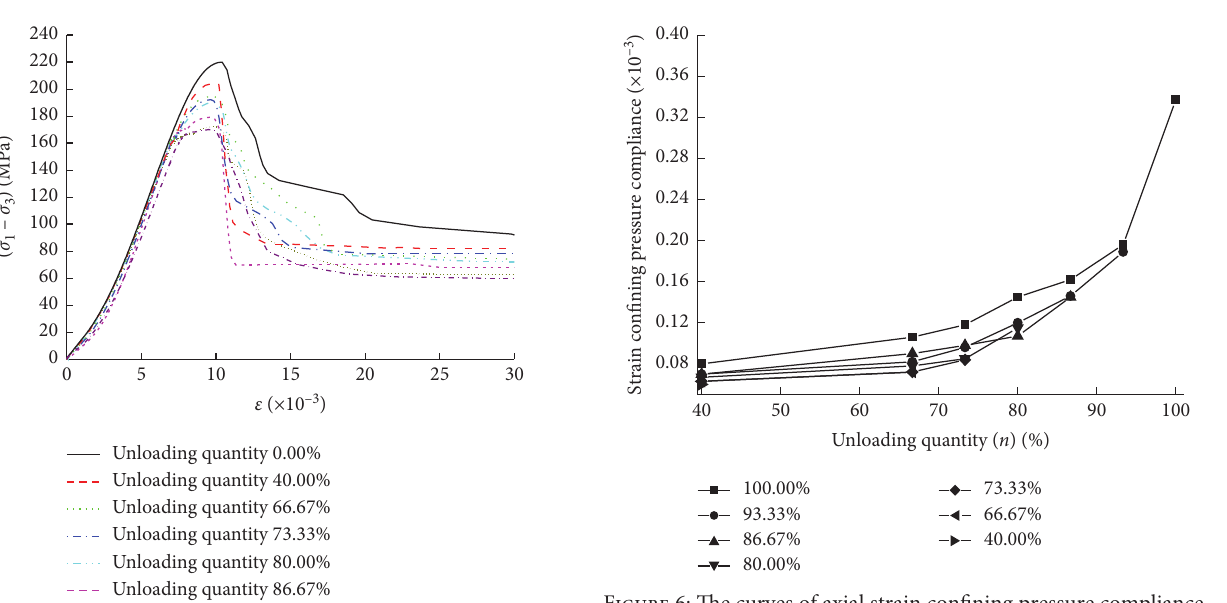
Figure 6: The curves of axial strain confining pressure compliance and unloading quantity in the unloading stage.